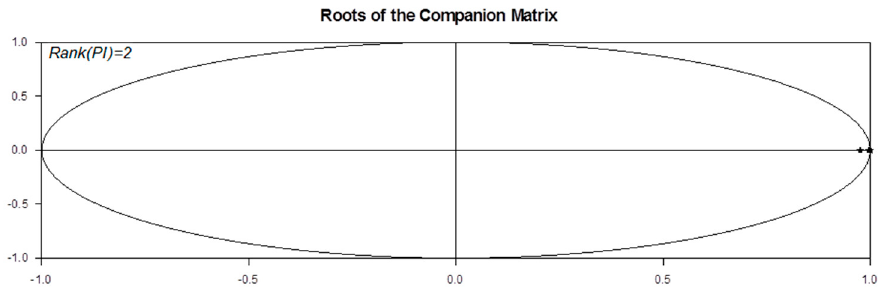
Figure 2. Unit roots matrix.